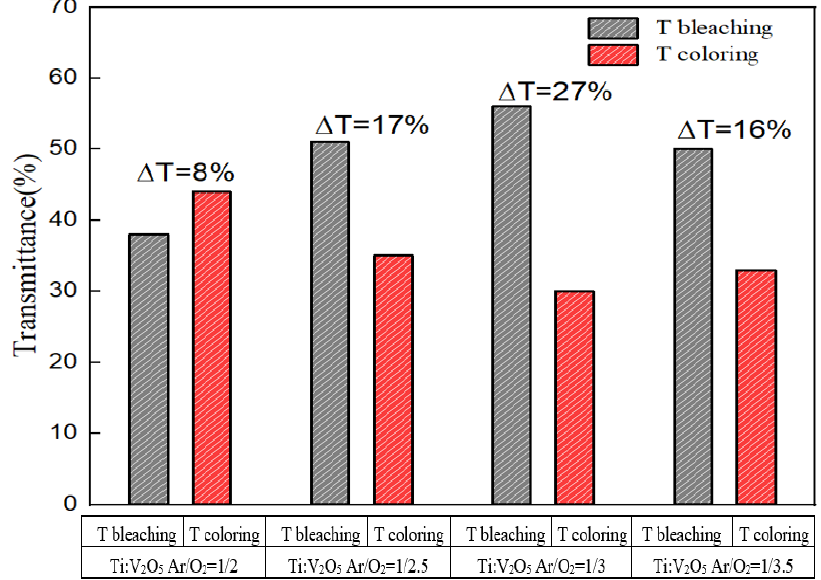
Figure 5. The difference in coloring/bleaching transmittance modulation of Ti:V 2 O 5 electrode films.